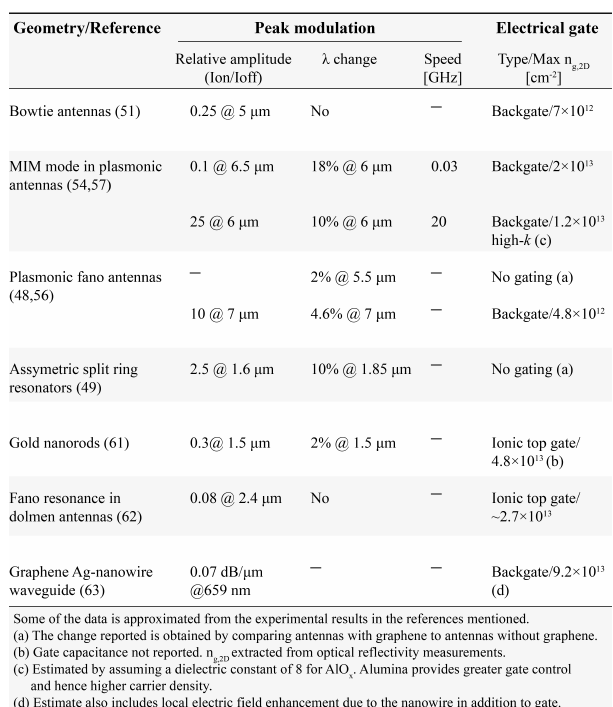
Table 1: Comparison of different approaches reported in literature demonstrating modulation of plasmonic resonance with